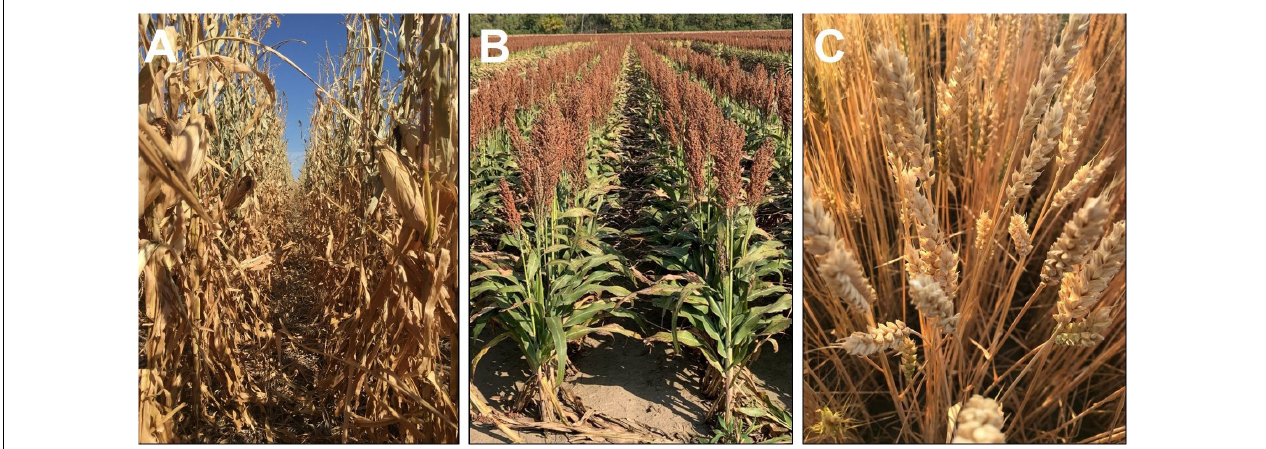
FIGURE 2 | Visual comparison of plant greenness of maize ( A ; Photo credit to Rachel Veenstra), grain sorghum (B) , and winter wheat (C) after physiological maturity and close to harvest maturity. Each image was captured when the respective crop was ready for mechanical